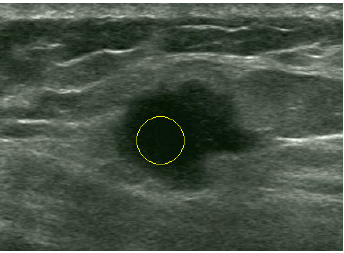
Figure 9. Localized tumor region.